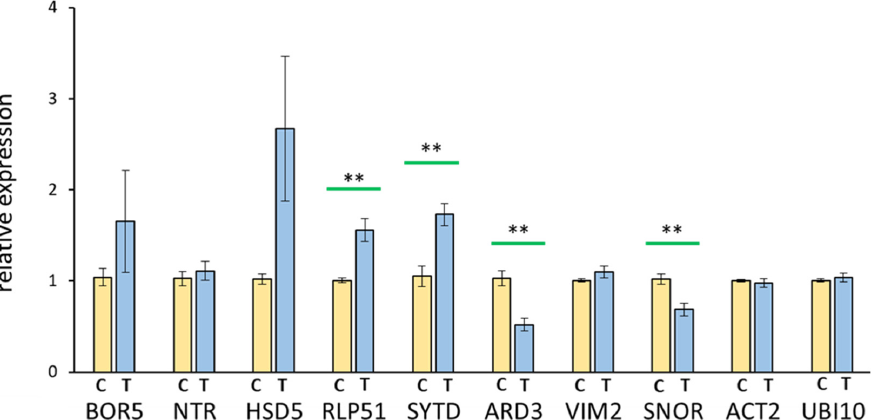
Figure 4. Quantitative qRT-PCR. Representation of the relative transcript amounts of the targets BOR5 , NTR, HSD5 , RLP51 , SYTD , ARD3 , VIM2, and SNOR (see text for details) from the treatment (T) and control (C) cDNA. The values were normalized on the control and the housekeeping transcripts Actin and Ubiquitin [37]. Relative transcript amount to control and reference genes actin and ubiquitin. Data were obtained in four independent experiments with replication, n = 8, means ± SE, Student’s t -test, and p < 0.01 **, indicated by green bars.